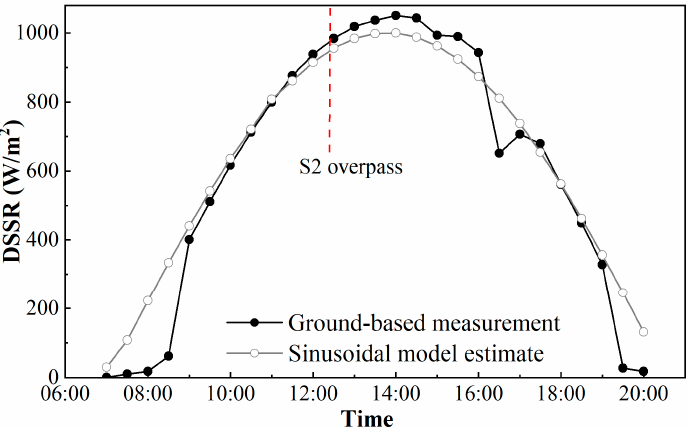
Figure 13. Comparison of diurnal variation in shortwave solar radiation data obtained with the sinusoidal model and ground measurements on 7 August 2018.